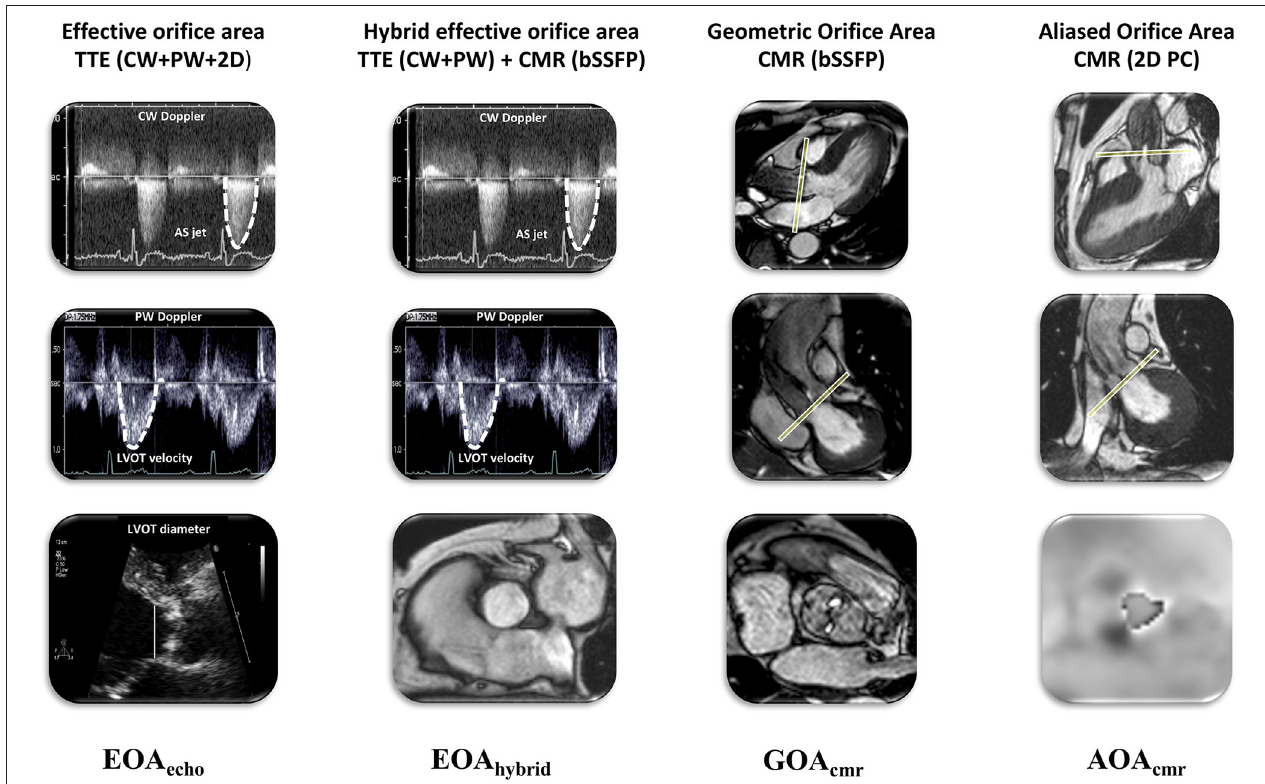
FIGURE 1 | Summary of different methods for non-invasive assessment of aortic valve area and grading of aortic stenosis severity: EOA by TTE, hybrid EOA by TTE and CMR, GOA and EOA by CMR. AOA, aliased orifice area; EOA, effective orifice area; CMR, cardiovascular magnetic resonance; GOA, geometric orifice area; echo, echocardiography; hybrid, combined echo-CMR assessment; TTE, transthoracic